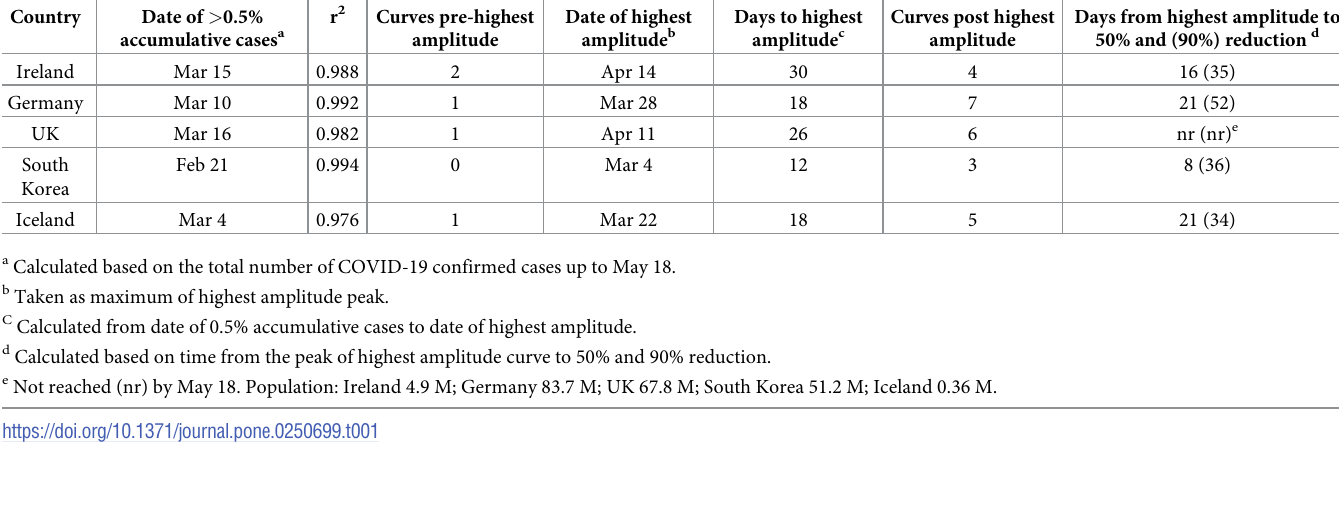
Table 1. Comparison of fitted logistic curve data for different countries.